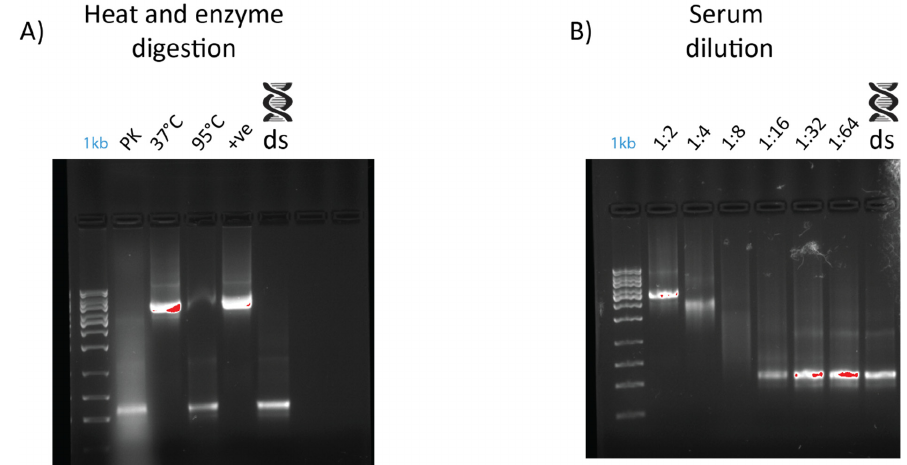
Figure 3. Effects of dilution, heat treatment, and enzymatic digestion on dsRNA–protein gel mobility shift. Serum was extracted from Cherax quadricarinatus and incubated with 400 ng of dsRNA for gel shift assays. ( A ) Serum was diluted to 1:2, 1:4, 1:8, 1:16, 1:32, and 1:64 ratios and incubated with the same quantity of dsRNA with a negative control of dsRNA + water as a comparison. ( B ) Serum was subjected to digestion by proteinase K overnight at 37 °C (“PK” lane), with a control at 37 °C overnight (“37 °C” lane) to ensure any serum degradation was a result of enzyme activity rather than temperature. Serum was also heated to 95 °C (“95 °C” lane) for five minutes to test the stability of dsRNA binding components and determine if they were proteinaceous in nature. A positive control (“+ve” lane) of fresh serum and dsRNA and a negative control of dsRNA and water (“ds” lane) were included as a comparison.